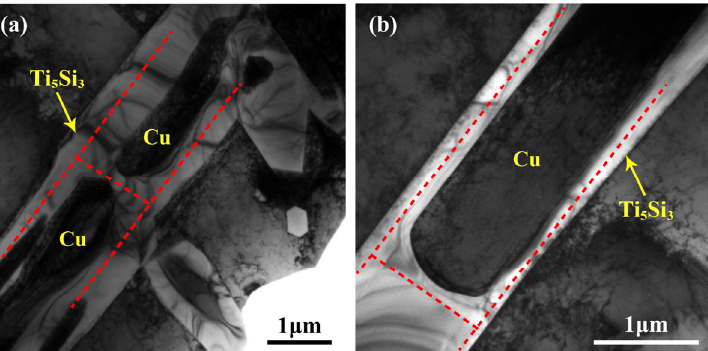
Figure 7. Microstructure of the longitudinal section direction of the core–shell structure Cu@Ti 5 Si 3 . ( a ) H ‐ shaped; ( b ) U ‐ shaped [25].